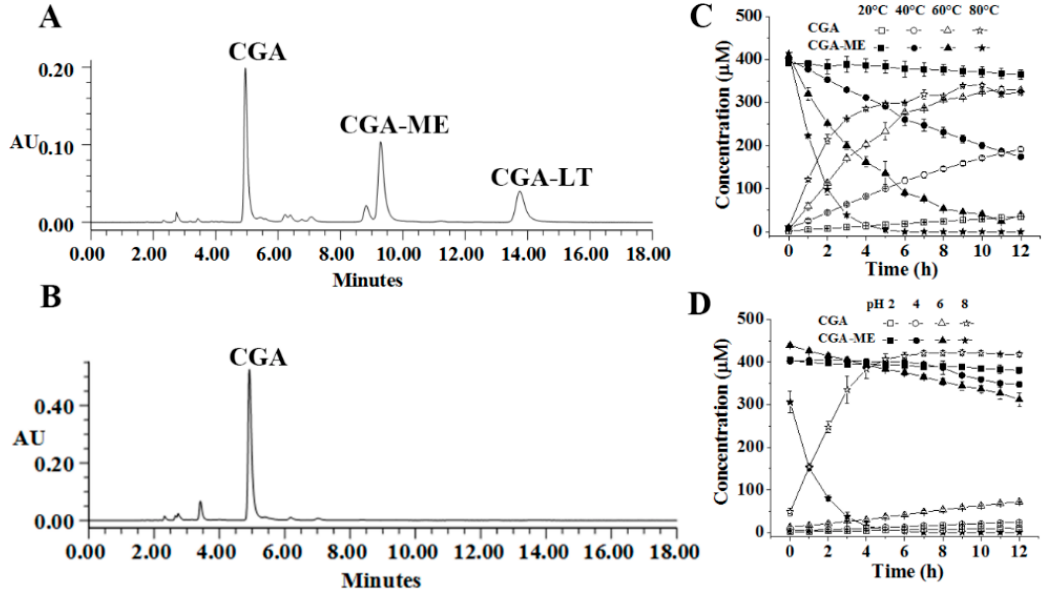
Figure 2. Representative UPLC chromatograms of trans -caffeoyl-6- O - D -gluconic acid methyl ester (CGA-ME) in the exposed solution at 40 °C ( A ) and pH 8 ( B ) after 12 h; Time–concentration curves of CGA-ME and CGA at different temperatures ( C ) and pH values ( D ).